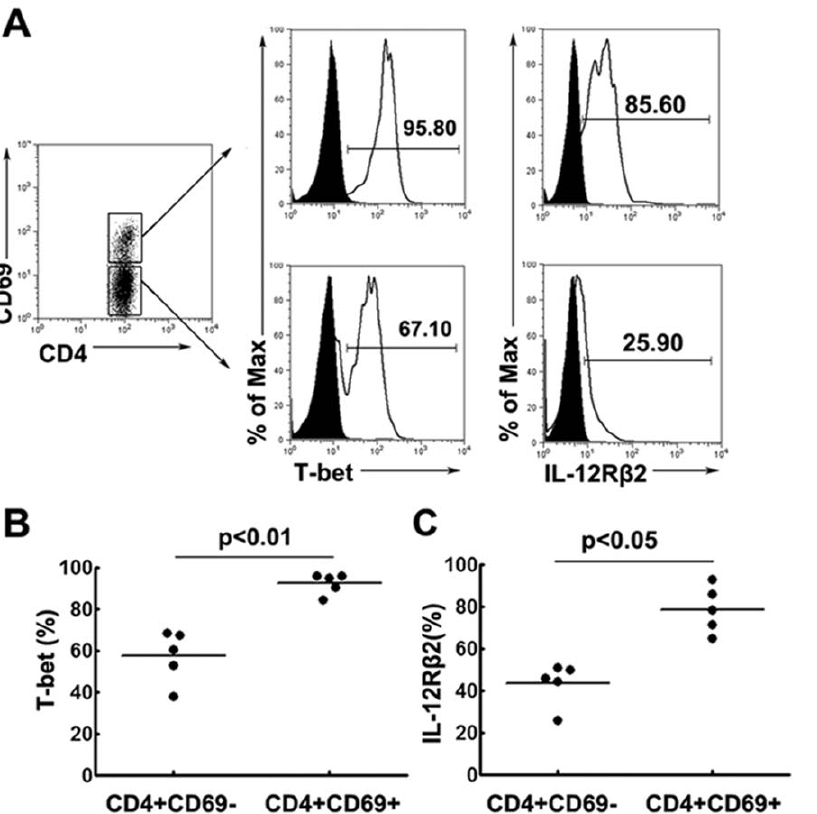
Figure 2. Expression of T-bet and IL-12R b 2 by CD4 + CD69 + and CD4 + CD69 2 T cells as assessed by direct ex vivo staining. (A) Expression of T-bet and IL-12R b 2 was evaluated on CD4 + CD69 + and CD4 + CD69 2 T cells by flow cytometry. (B, C) Summary data of T-bet (B) and IL-12R b 2 (C) expression on CD4 + CD69 + and CD4 + CD69 2 T cells derived from five independent experiments are represented.